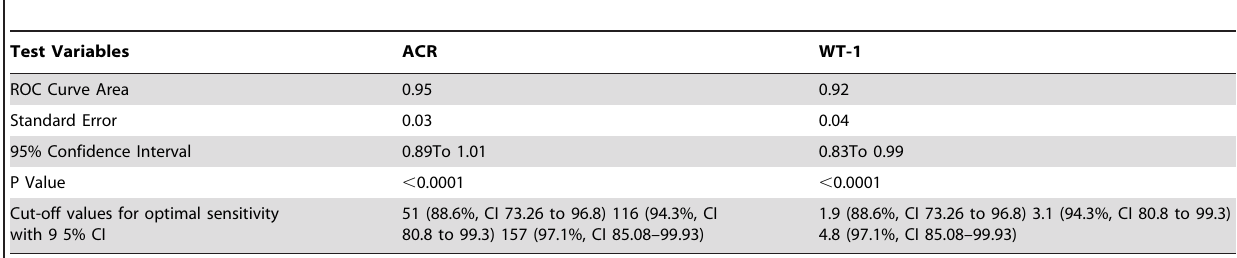
Table indicate data obtained from Receiver-operator characteristics (ROC) curve analysis. An AUC value of 0.5 indicates no discriminative value while the maximum value for the AUC is 1.0 which indicates perfect test. The 95% Confidence Interval is the interval in which the true (population) Area under the ROC curve lies with 95% confidence.